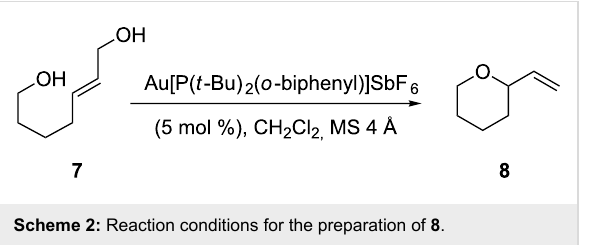
Scheme 2: Reaction conditions for the preparation of 8 .